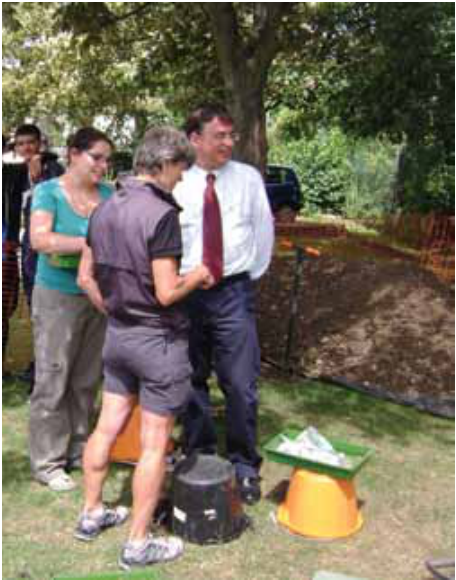
Fig. 4: Sarah Dhanjal and Jill Hickman of Hendon School explaining the